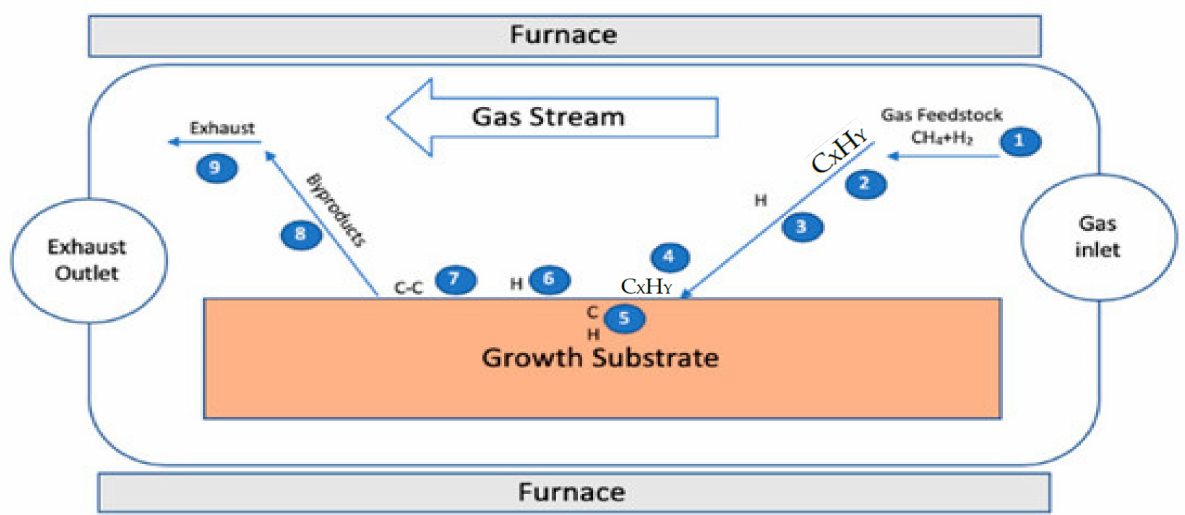
Figure 7. Schematic representation of the CVD method for graphene [Reprinted with permission from ref. [67], Saeed, M.; Alshammari, Y.; Majeed, S.A.; Al-Nasrallah, E. Chemical Vapour Deposition of Graphene Synthesis, Characterisation, and Applications: A Review. Molecules 2020 , 25 , 3856. https://doi.org/10.3390/molecules25173856, Copyright ©